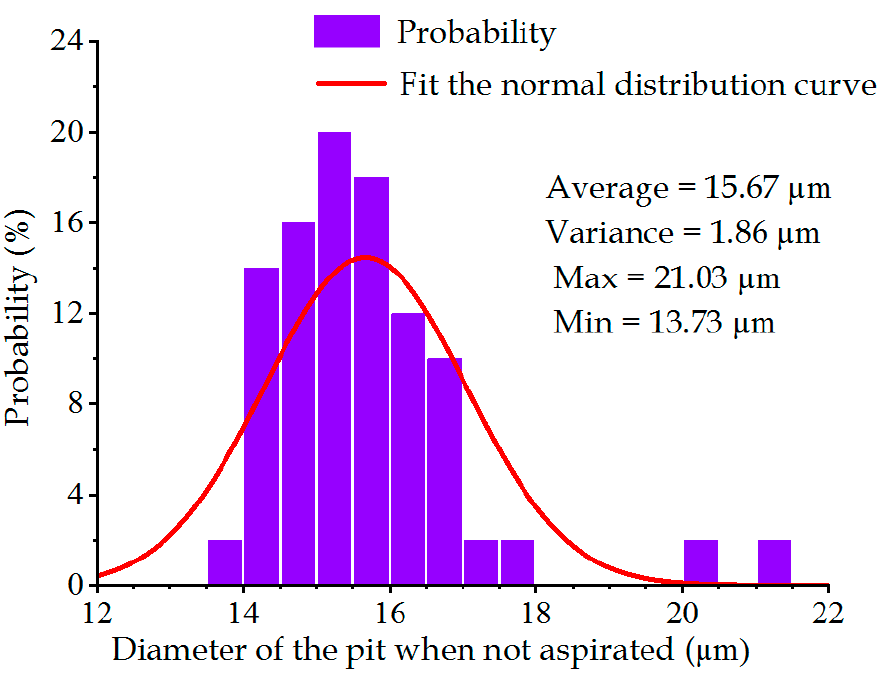
Figure 13. Distribution of pit diameters under the non-aspirated state.